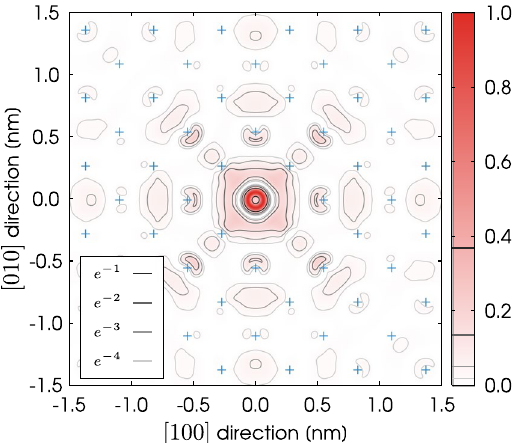
Figure 1. A two dimensional slice of the probability density ψ ( ) 2 for the phosphorus donor electron inside the dopant plane. The wavefunction of the donor electron has been calculated using a supercell of 10,648 atoms and the maximum of the probability density has been normalized to one. The contours show where this probability density is equal to a negative integer power of e . The blue pluses mark the positions of the in-plane silicon atoms.